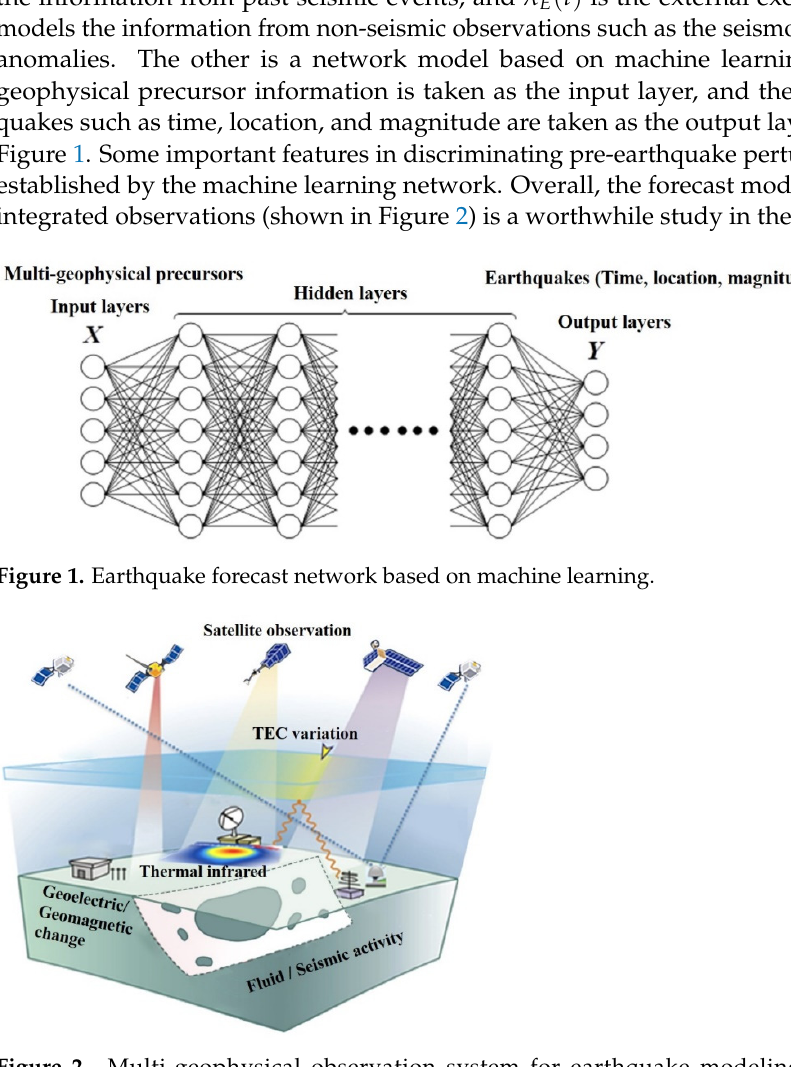
Figure 2. Multi-geophysical observation system for earthquake modeling and forecasting (modified from [83]).